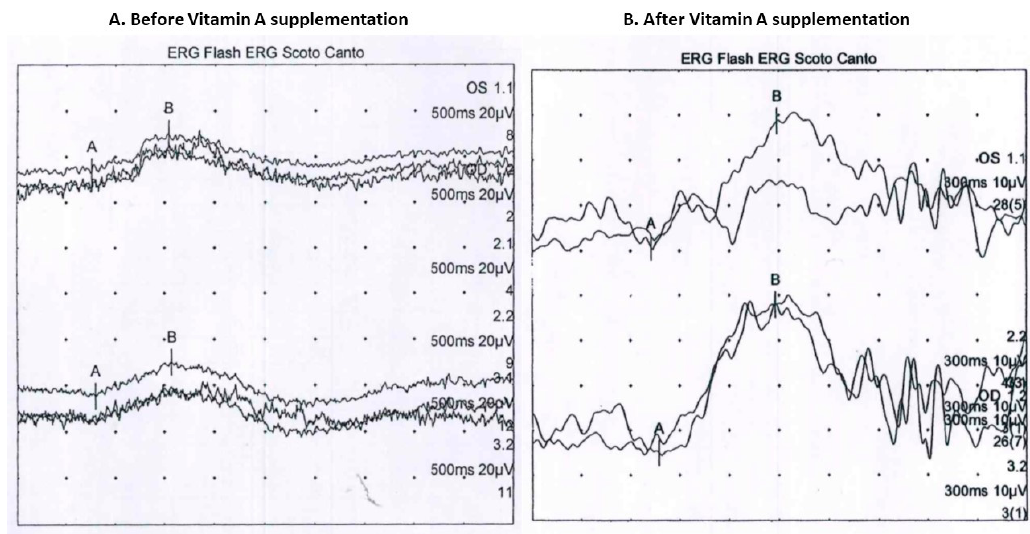
Figure 2. Patient’s full-field electroretinogram (ERG) ( A ) before vitamin A supplementation: decreased scotopic responses in both eyes and depressed photopic response in the left eye; ( B ) after vitamin A supplementation: normal.